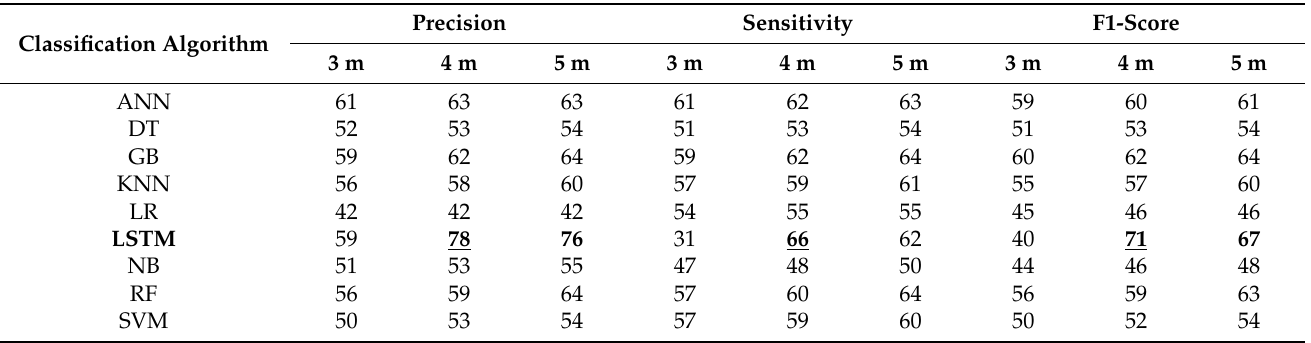
Table 6. Classification performance of collar-fitted accelerometer sensor based on nine algorithms framed at different minute window sizes for specific behavior of